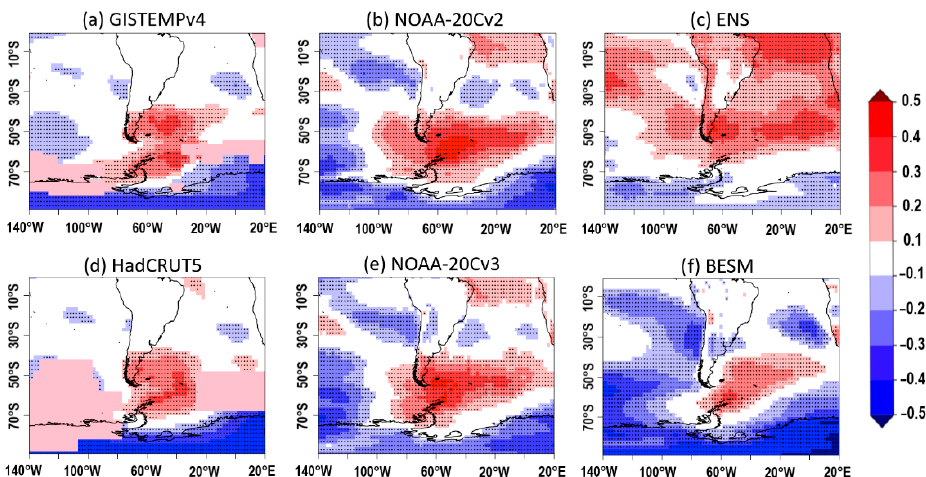
Figure 6. SAM index correlation with monthly surface temperature anomalies (1979–2005). ( a ) GISTEMPv4, ( b ) NOAA-20Cv2 reanalysis, ( c ) CMIP5 ensemble mean, ( d ) HadCRUT5, ( e ) NOAA-20Cv3 reanalysis, ( f ) BESM. GISTEMPv4 and HadCRUT5 temperature anomalies were correlated with Marshall observational index, while reanalysis and models’ temperature anomalies were correlated with GW99 index. Dotted areas correspond to 5% significance level.